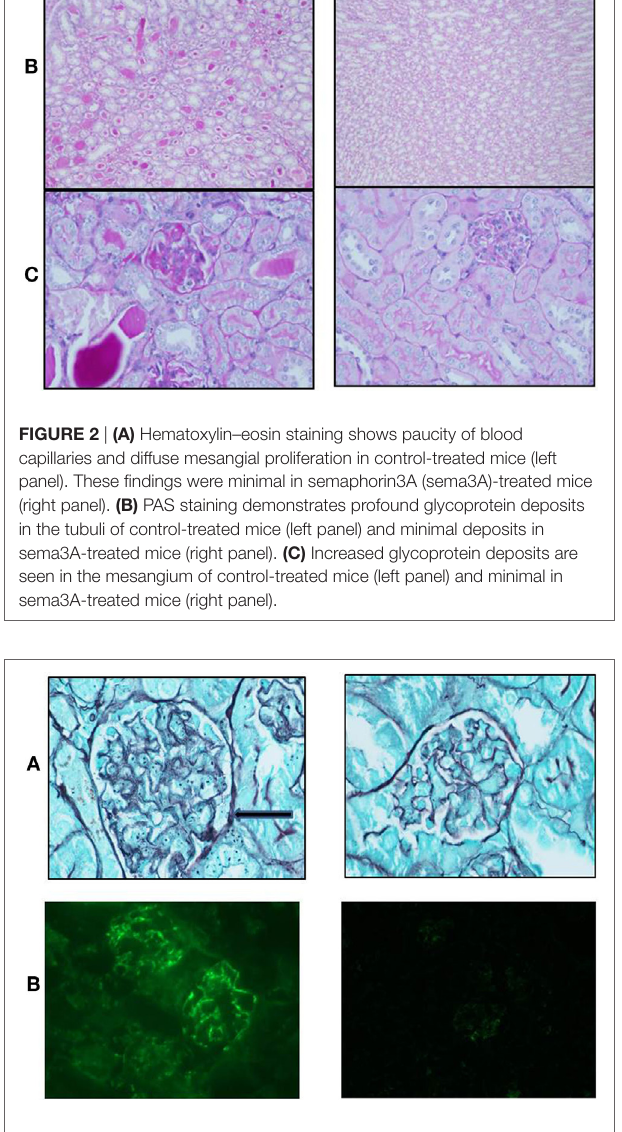
FigUre 4 | Survival rate is much longer in semaphorin3A (sema3A)-treated mice and shorter in control-treated mice.